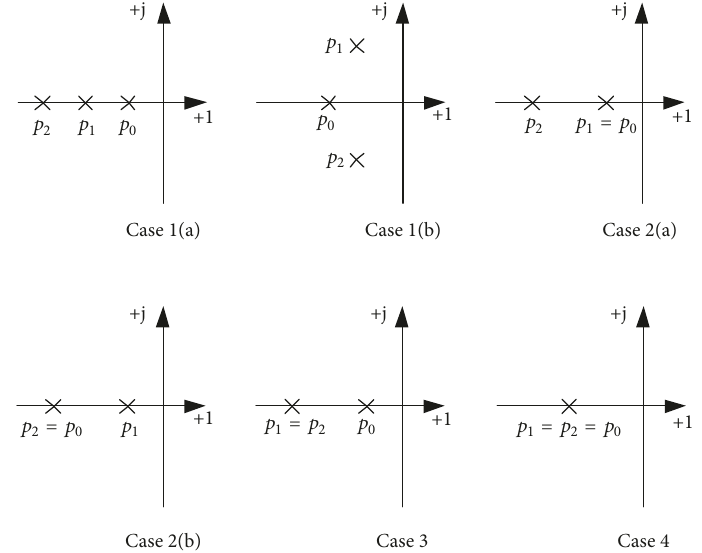
Figure 4: Pole distributions of UFR transfer